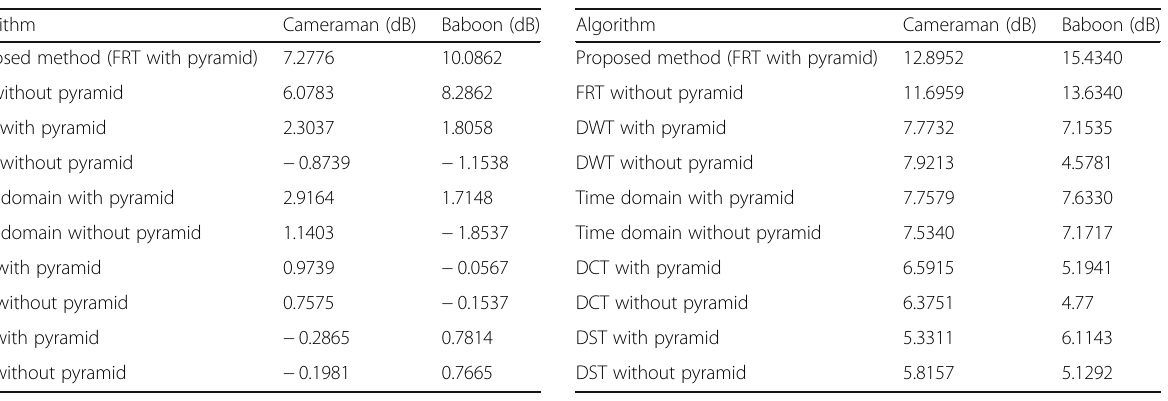
Table 2 PSNR of overall separation performances on